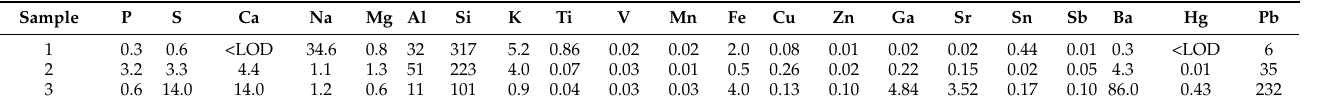
Table 2. ICP-MS results in mg · g − 1